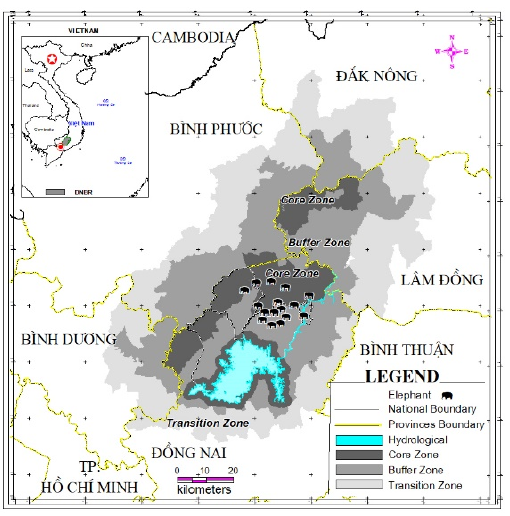
Figure 1. Map of the DNBR (revised from [68]).